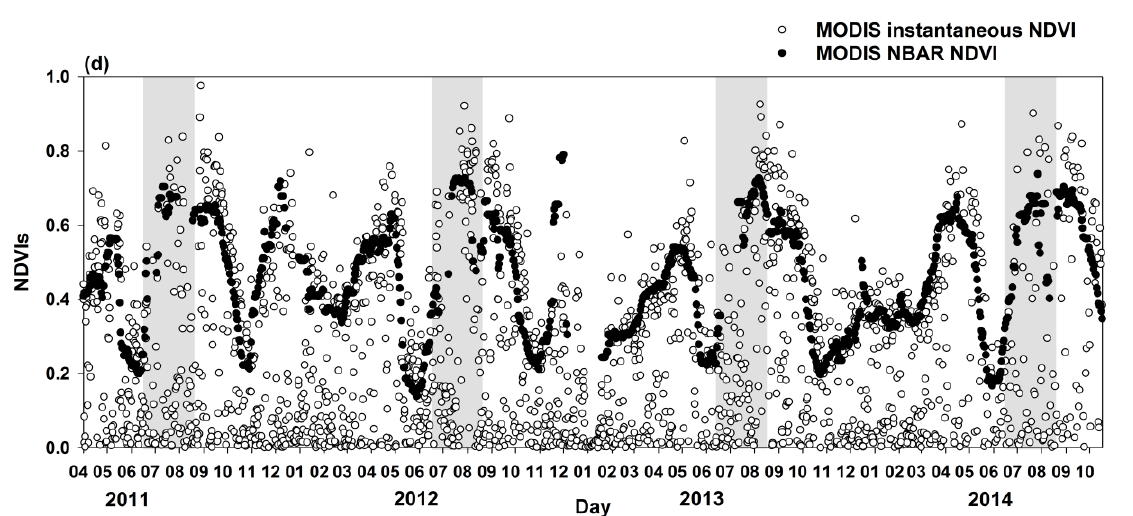
Figure 5. Comparisons of the temporal NDVI variation derived from GOCI and MODIS. The GOCI NDVI profiles for BAR (solid circles) and instantaneous measurement of NDVI (open circles) over ( a ) intermediate-late maturing paddy rice, and ( b ) early maturing paddy rice; MODIS NBAR (solid circles) and instantaneous measurement of NDVI (open circles) profiles over ( c ) intermediate-late-maturing paddy rice, and ( d ) early maturing paddy rice. The four light gray areas from middle June to middle August are rainy summer seasons in South